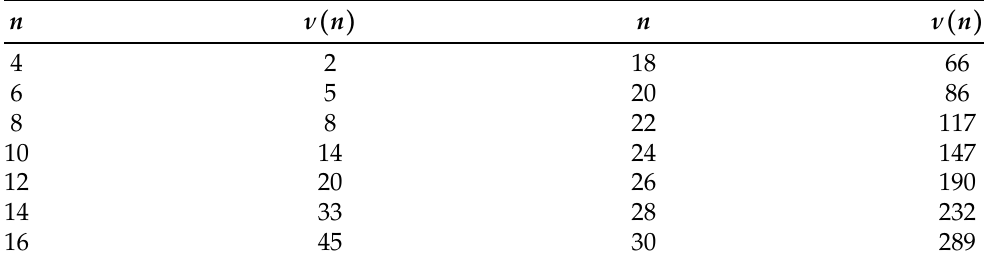
Table 1. Table of n and ν ( n )